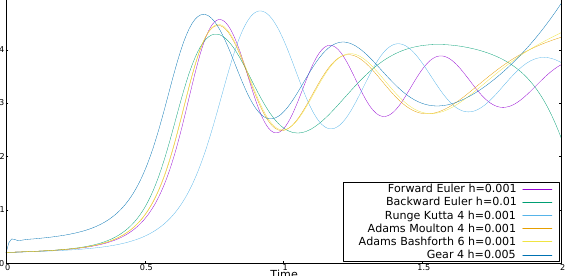
Figure 4. Time series of w of HO5 given in Table 1 with initial conditions x 0 = y 0 = z 0 = w 0 = 0.2. The D KY is evaluated from the Lyapunov exponents [9], and for an n -dimensional system it is evaluated by Equation (3), where LE 1 , . . . , LE n are Lyapunov exponent values ordered from the highest to the lowest